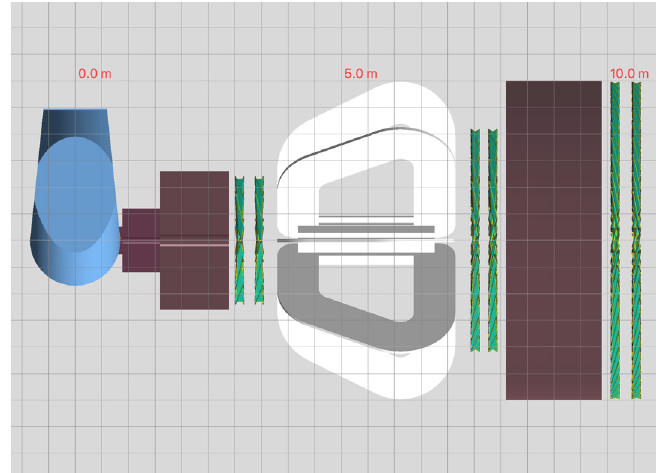
Figure 1. Conceptual design of the NA60 + experimental apparatus. The figure represents the set-up adapted to low-energy collisions, with a thinner hadron absorber and the muon spectrometer relatively closer to the